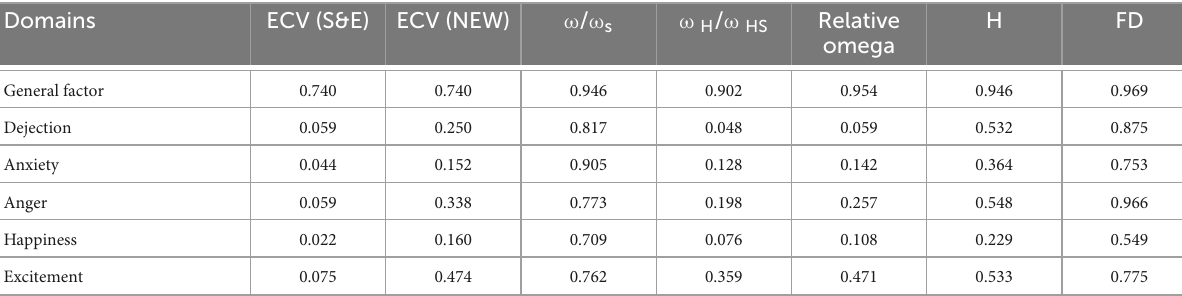
TABLE 5 Bifactor indices for the specified